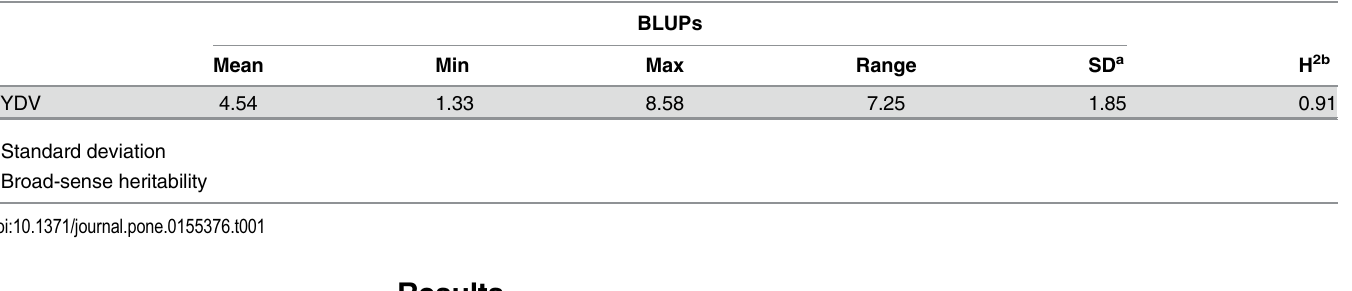
Table 1. Descriptive statistics and broad sense entry-mean heritability for BLUPs for BYDV tolerance in 428 spring oat lines.